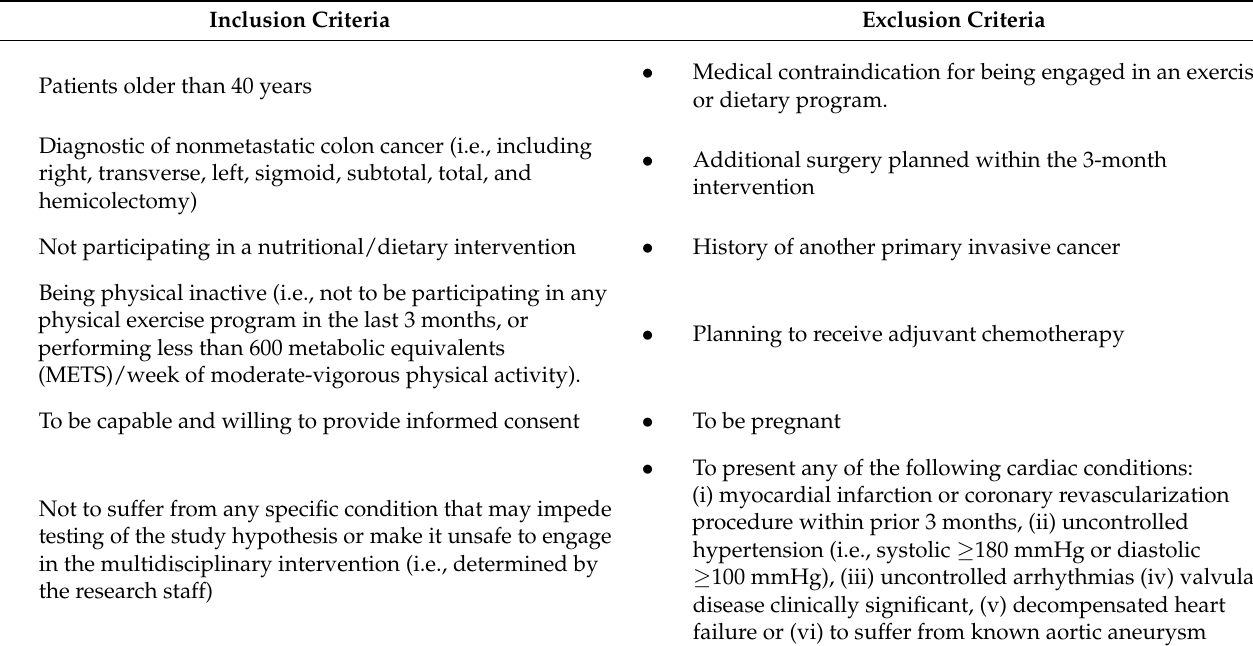
Table 1. Inclusion and exclusion